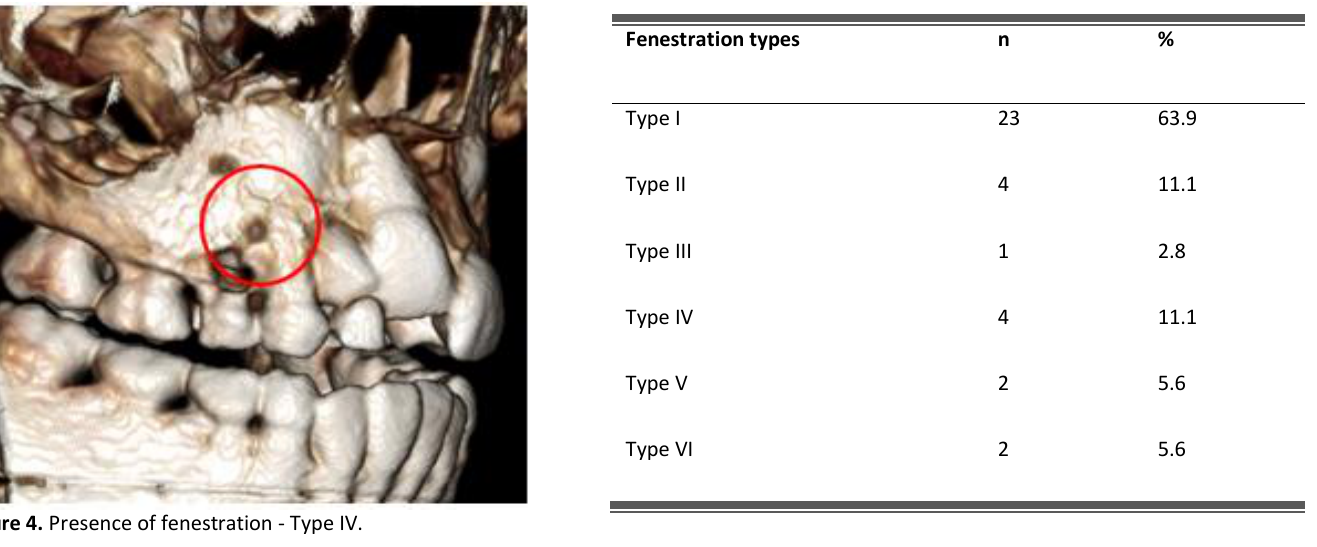
Table 2. Types of fenestration: